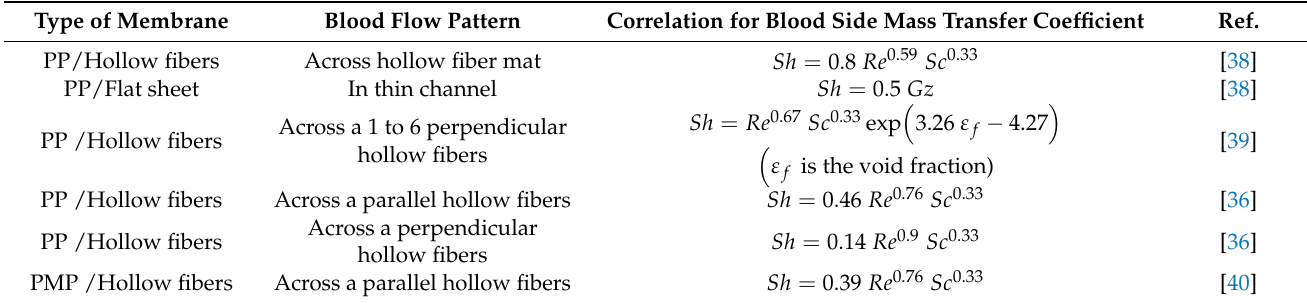
Table 2. Mass transfer correlations for different blood oxygenator devices.